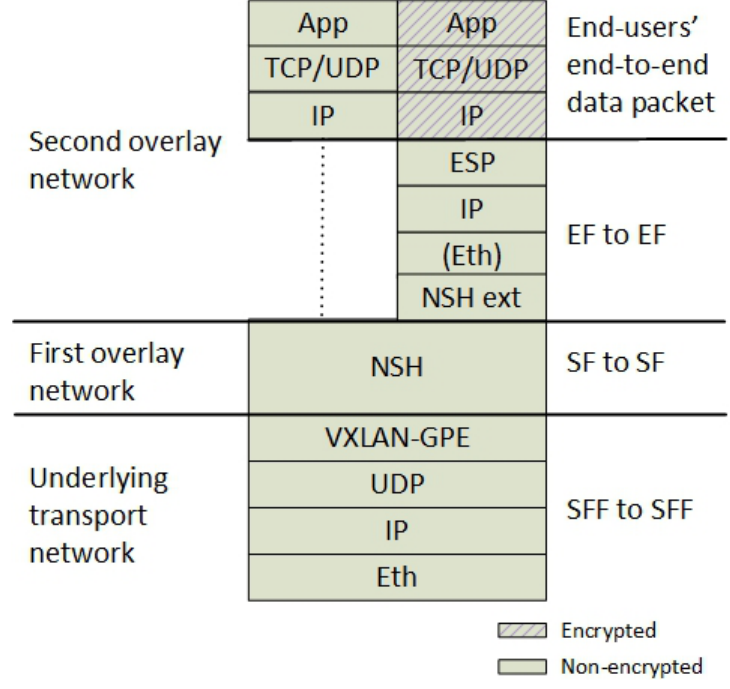
Figure 4. The layered network